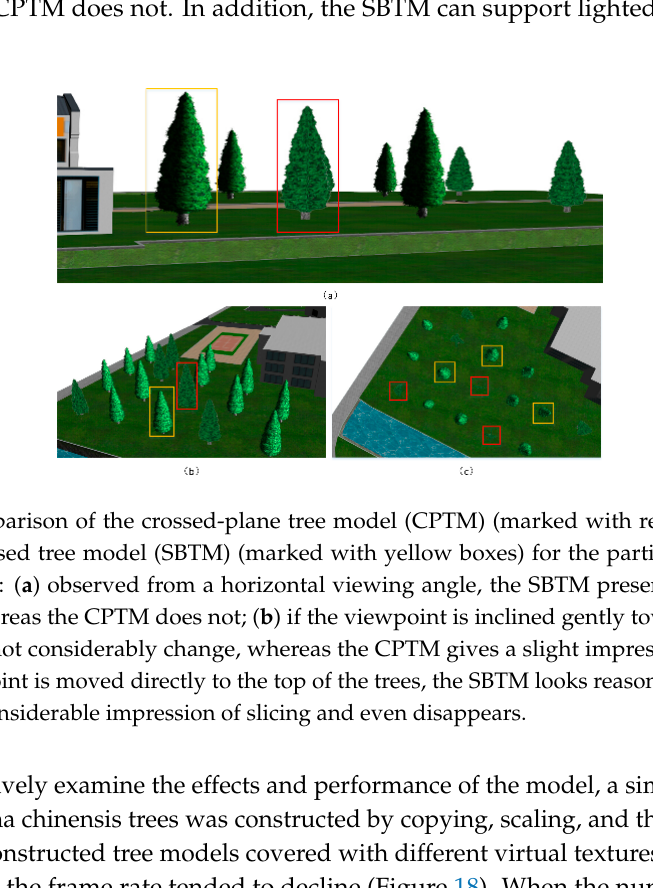
200 Figure 16. Frame rate curves for the rendering of a single tree model in different scenarios on a 1440